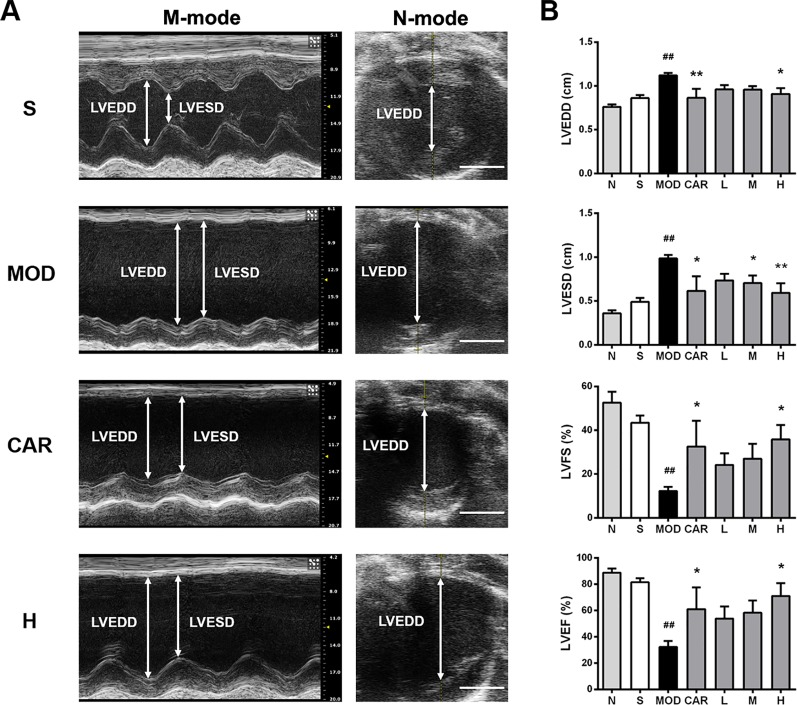
Effect of Shenfu injection on the echocardiographic characteristics of the rats with ischemic heart failure. (A) M-mode and B-mode echocardiographic images of the hearts of rats in the S, MOD, CAR, and H groups. (B) Left ventricular end-diastolic diameter (LVEDD), left ventricular end-systolic diameter (LVESD), left ventricular fraction shortening, and left ventricular ejection fraction of the rats with IHF. Arrows demarcate the LVESD and LVEDD dimensions; scale bar, 5 mm. N, normal (n = 3); S, sham (n = 3); MOD, model (n = 4); CAR, carvedilol (n = 4); L, 3 ml/kg Shenfu injection (n = 5); M, 6 ml/kg Shenfu injection (n = 4); H, 12 ml/kg Shenfu injection (n = 4). Data are expressed as the mean ± standard error of the mean. ##
P < 0.05 vs. S group; *P < 0.05, **P < 0.01 vs. MOD group.